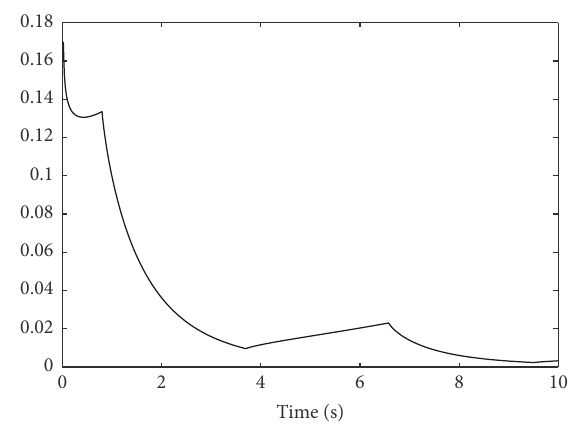
Figure 3: The evolution of 𝑥 𝑇 (𝑡)𝜀 of system